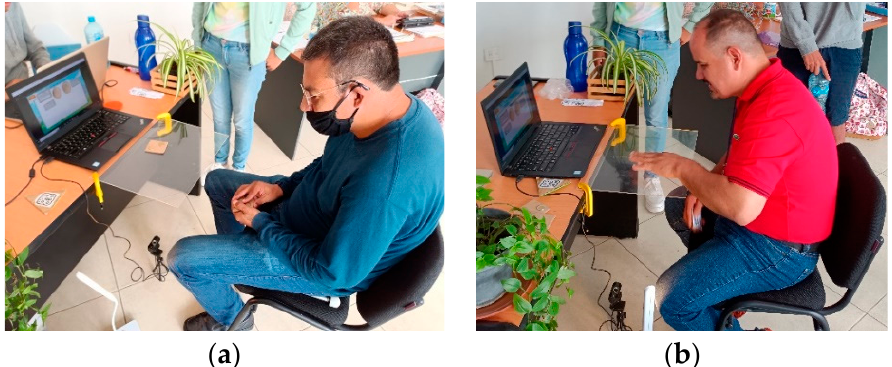
Figure 7. ( a ) Blind person listening to feedback from the system. ( b ) Blind person interacting with the tangible interface.